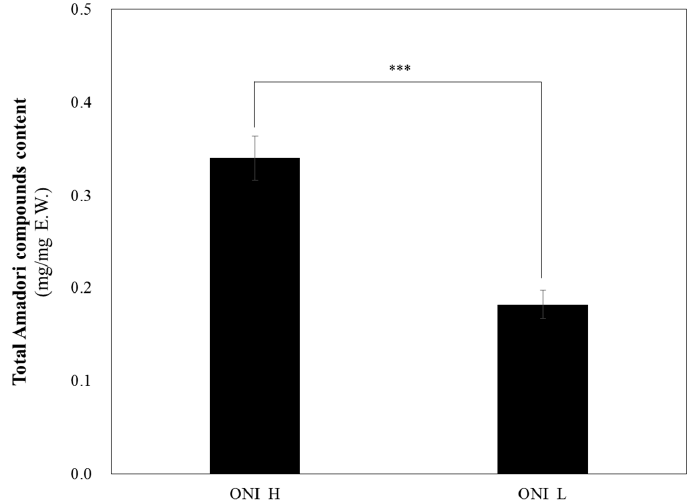
Figure 1. Total ARCs content of two different onion extracts (ONI_H and ONI_L). The results were expressed as mean ± S.D. Statistical significances were determined by Student’s t -test (*** p < 0.001).